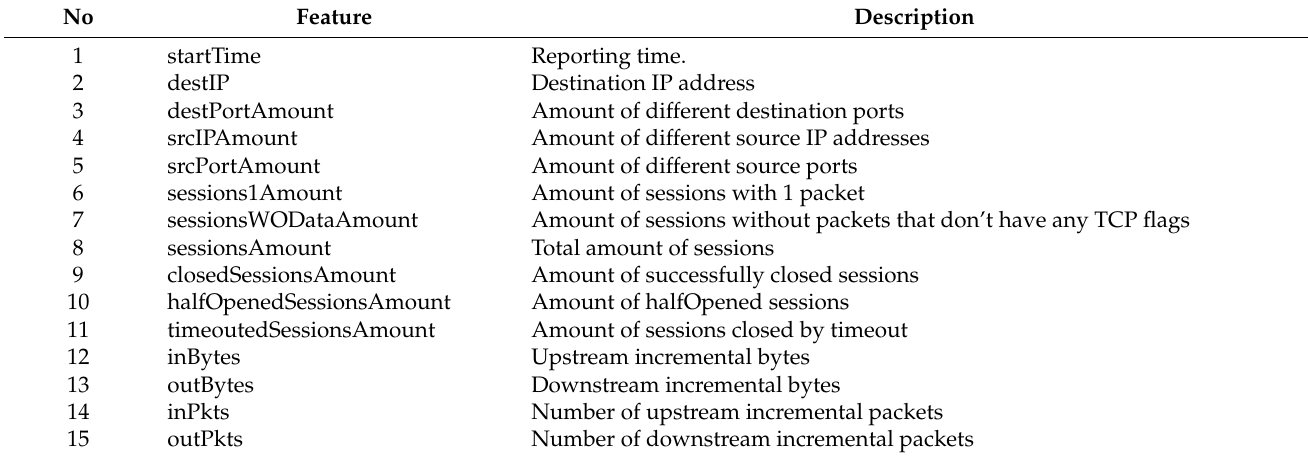
Table 2. Traffic features for detection of DDoS